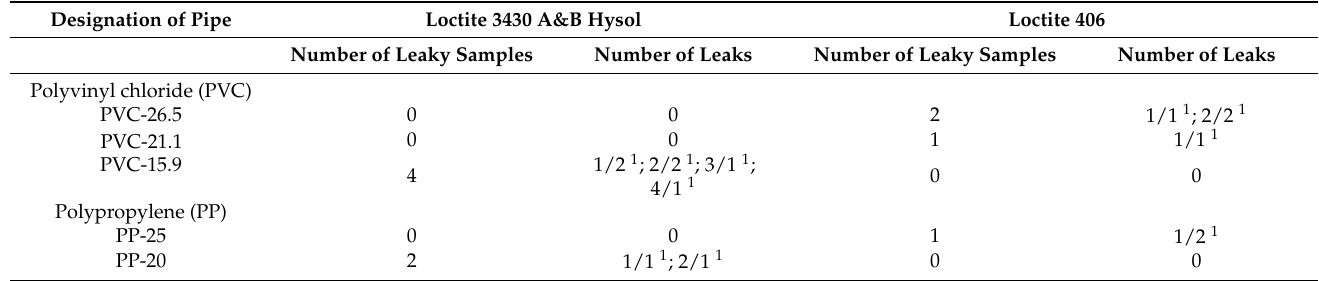
Table 4. Number of leaks found in samples of butt-adhesive joints tested for leak-tightness.